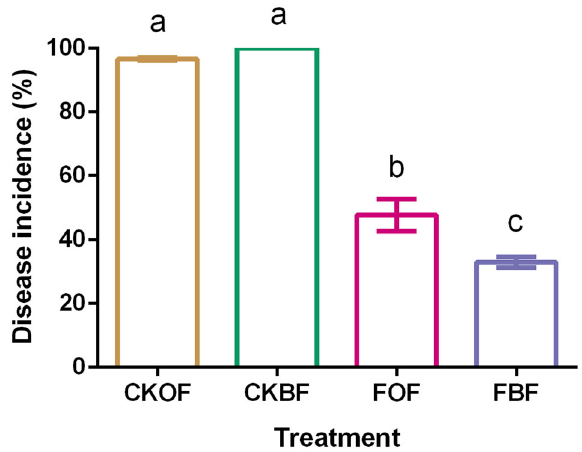
Fig. 1 Results regarding wilt disease in tomato plants 3 months after transplantation in 2015 spring season. CKOF: organic fertilizer was amended in un-fumigated soil; CKBF: bio-organic fertilizer was amended in un-fumigated soil; FOF: organic fertilizer was amended in fumigated soil; FBF: bio-organic fertilizer was amended in fumigated soil. All values are the mean of three replicates and error bar represents the standard deviation of mean. Bars with different letters indicate signi fi cant differences among the four treatments as de fi ned by Tukey ’ s test ( p <